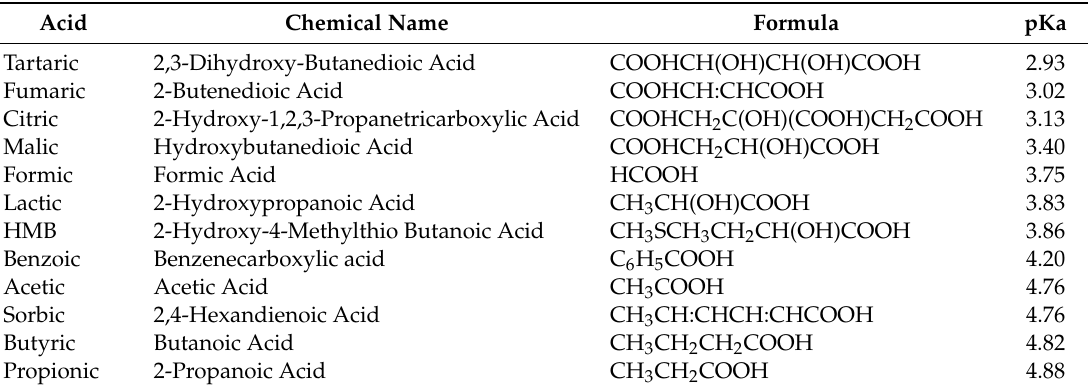
Table 1. List of acids and their